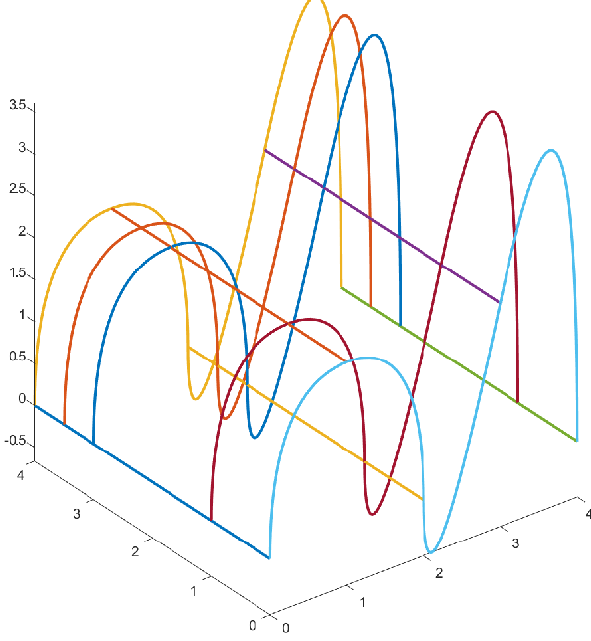
Figure 5. A curve network with m = R = 3, n = 4, S =